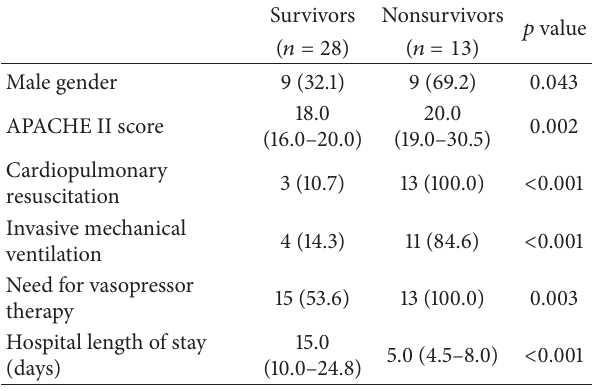
Table 5: Statistically significant factors for mortality in group 1 patients ( 𝑛 = 41